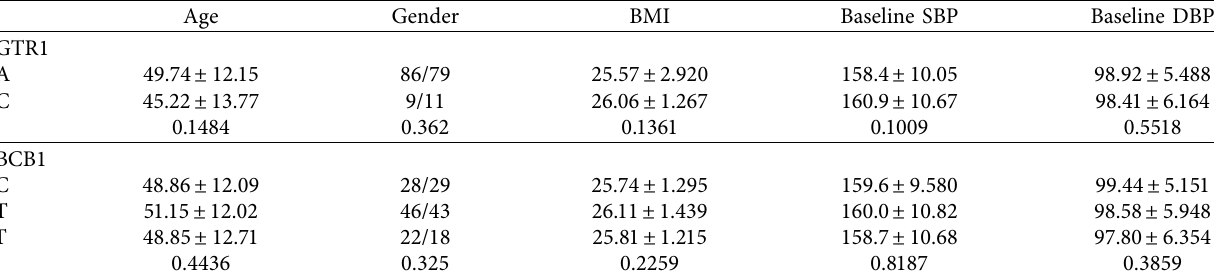
Table 3: Each genotype patient’s basic information illustrated no signifcant diference.